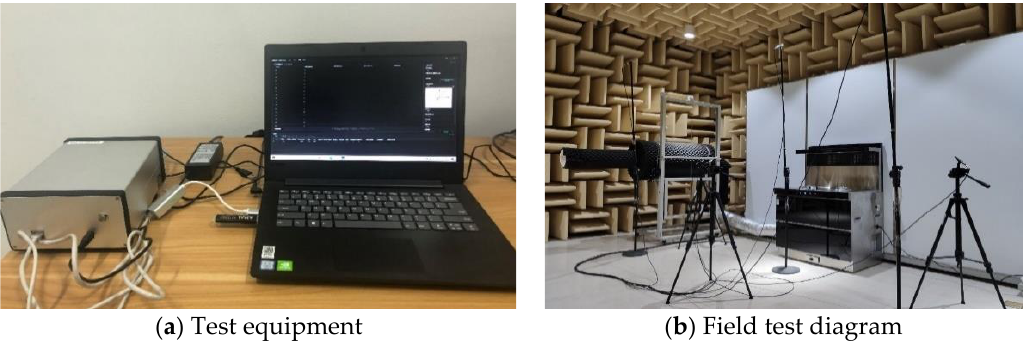
Figure 22. Integrated stove machine noise test diagram.